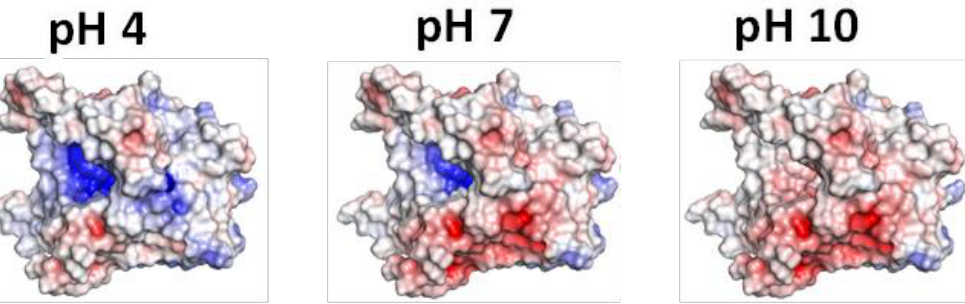
Figure 4. Electrostatic charge at the BCL surface calculated for pHs 4, 7, and 10. Red – white – blue scale refers to minimum ( − 5 kT/e, red) and maximum (5 kT/e, blue) surface potential.